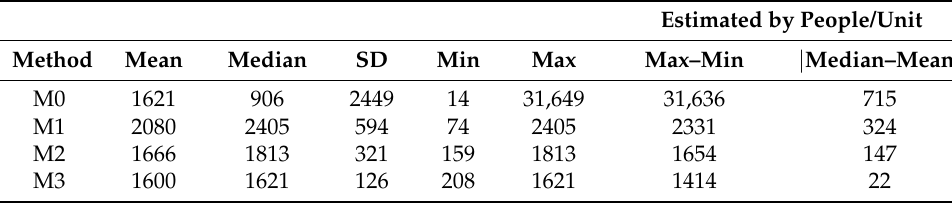
Table 4. Measures of service load of community care resources through methods